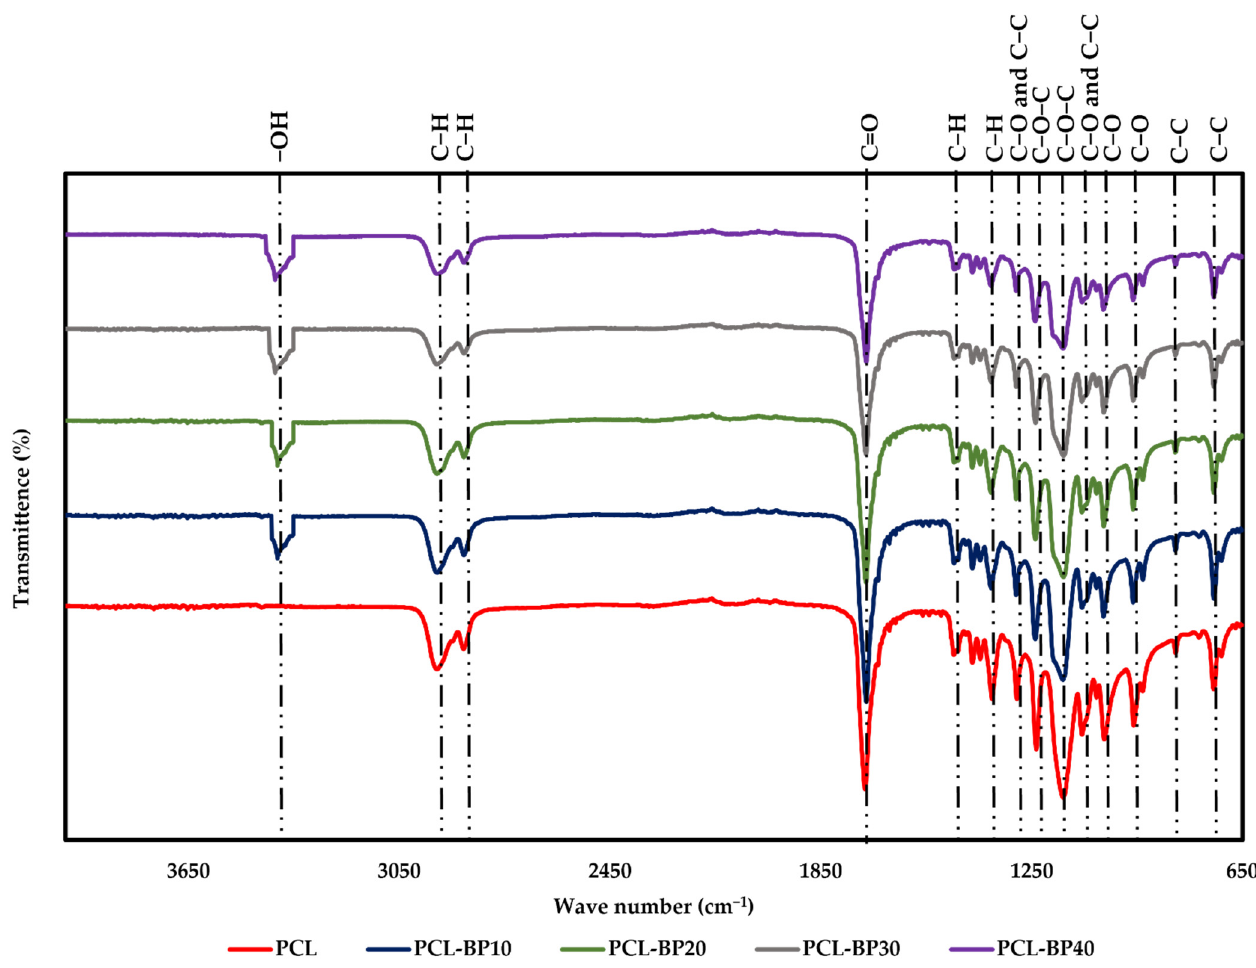
Figure 3. FTIR spectra of PCL and PCL-BP composites.